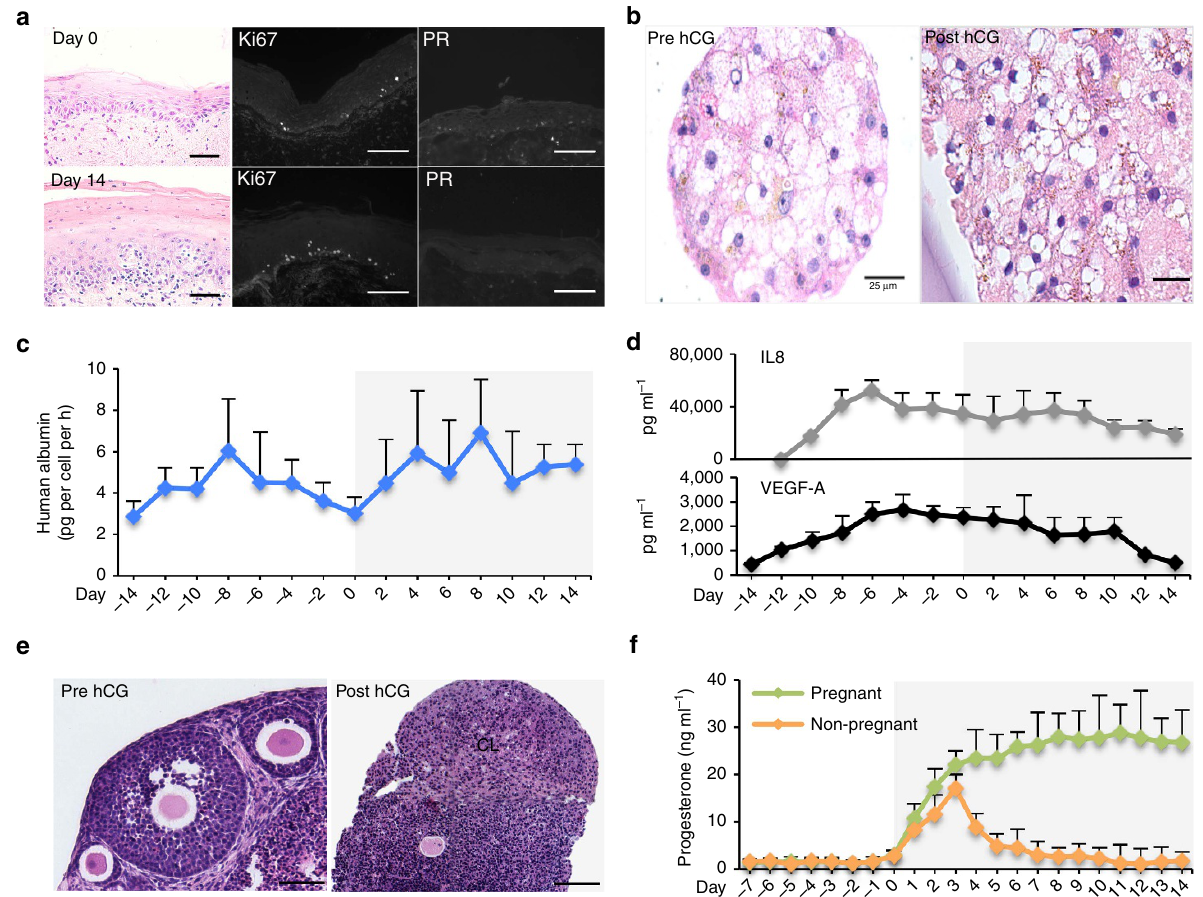
Figure 6 | The Quintet-MFP supported female reproductive and non-reproductive tissues and pregnancy-like hormone condition. ( a ) Ectocervix histology, and Ki67 and PR staining at the end of follicular (day 0) and luteal (day 14) phases. ( b ) Histology of liver microtissues before (day (cid:2) 14) and after (day 14) hCG treatment. ( c ) Human albumin production over 28 days of microfluidic culture. ( d ) Production of IL8 and VEGF over 28 days of microfluidic culture. ( e ) Histology of ovarian tissue in the Quintet-MFP on day 0 (pre hCG) and day 8 (continuously cultured with hCG). ( f ) Ovarian progesterone secretion with and without hCG treatment. Graphs in c , d , f display average þ s.d.’. Scale bar, 10 m m ( a ), 25 m m ( b ), and 100 m m ( e ). CL, corpus luteum; IL8, interleukin 8; VEGF-A vascular endothelial growth factor A. n ¼ 3 replicates of the integrated tissue culture in the